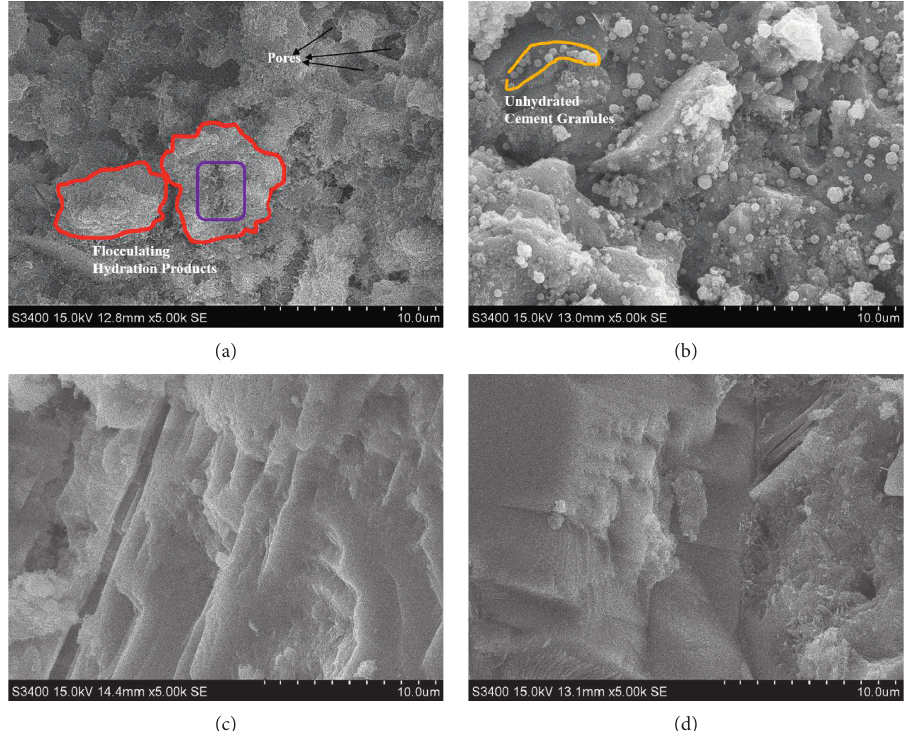
Figure 6: Mesomorphology of GTCM for 1 day: (a) GTCM-0 under the SC method; (b) GTCM-20 under the SC method; (c) GTCM-0 under the HWC method; (d) GTCM-20 under the HWC